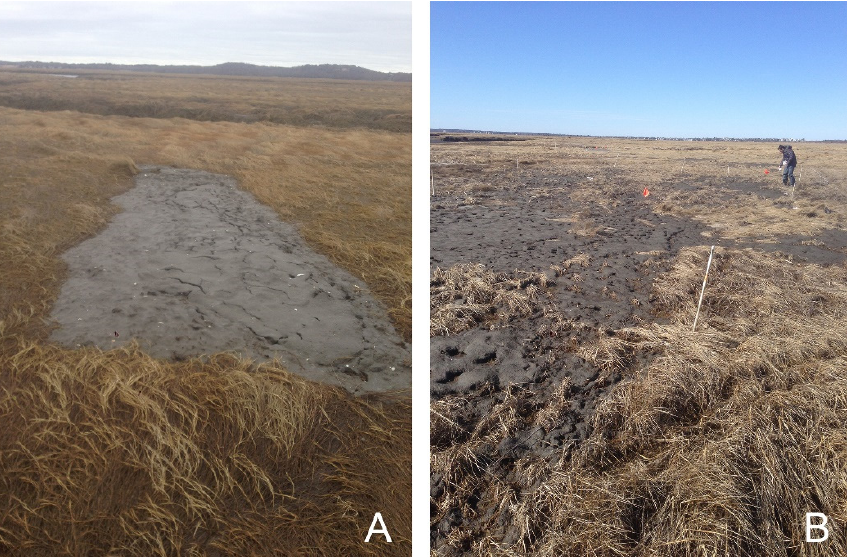
Figure 2. ( A , B )Examples of IRD sediment patches deposited by winter storm Grayson in Plum Is ‐ Figure 2. ( A , B ) Examples of IRD sediment patches deposited by winter storm Grayson in Plum land Estuary (PIE) in Massachusetts, USA, photos taken in April 2018. Island Estuary (PIE) in Massachusetts, USA, photos taken in April